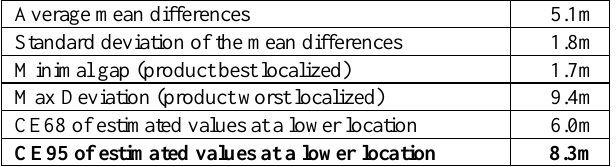
Figure 5. BDPHR footprints over Europe (in green).